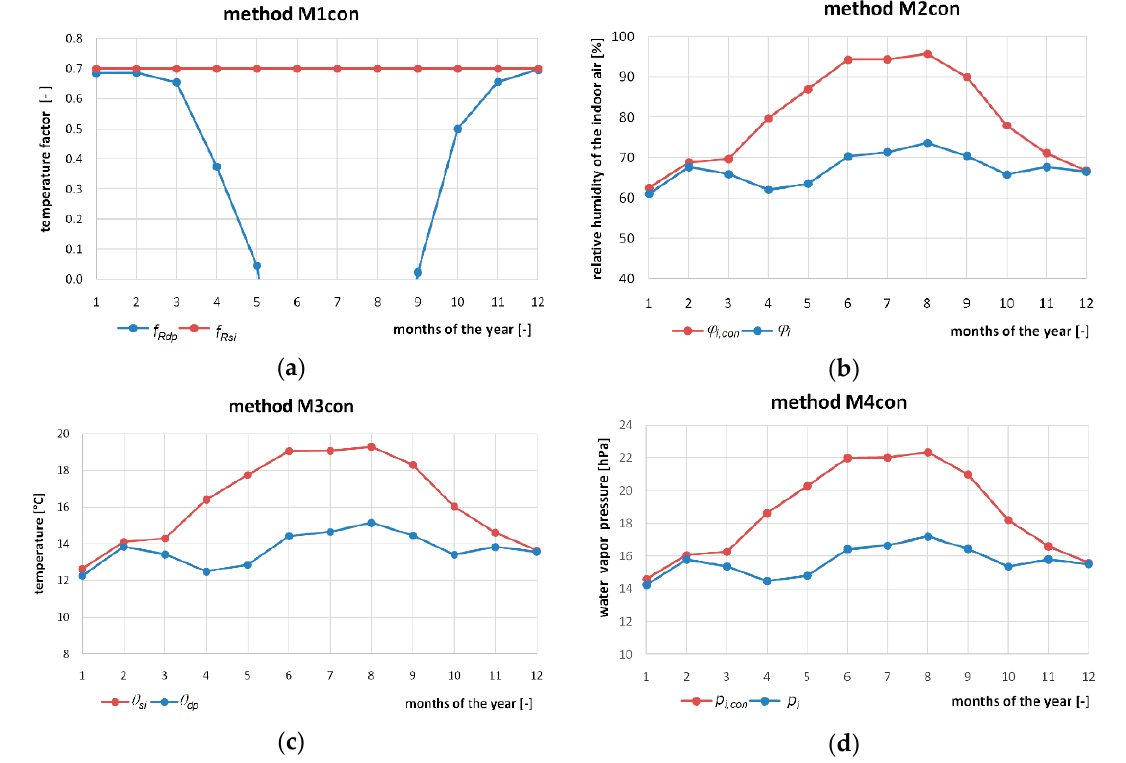
Figure 2. Characteristic graphs of parameters in the phenomenon of surface condensation.